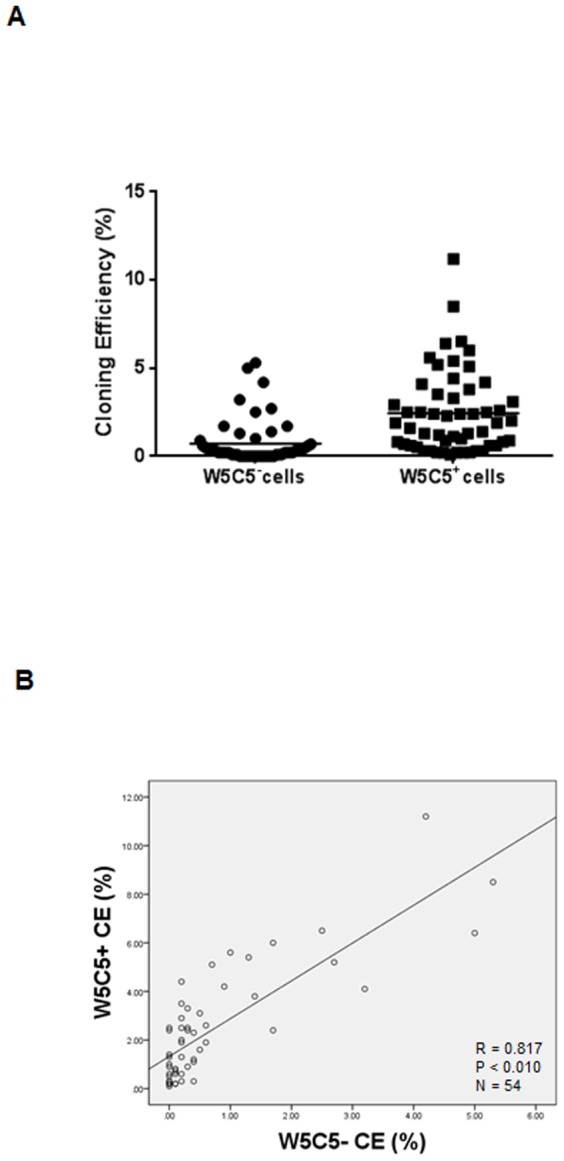
Cloning Efficiency (CE) of endometrial mesenchymal stem cells.(A) W5C5+ CE was significantly greater than W5C5− CE. Data are means ± SEM. Group comparison by Unpaired t test. ****P<0.0001. (B) Relationship between W5C5+ CE and W5C5− CE in all subjects (n = 54). Pearson correlation coefficient: (R = 0.817, P<0.01).